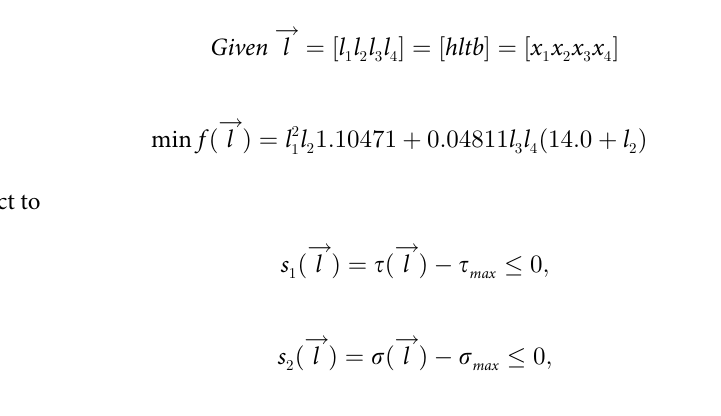
The WBD problem is formulated mathematically as follows